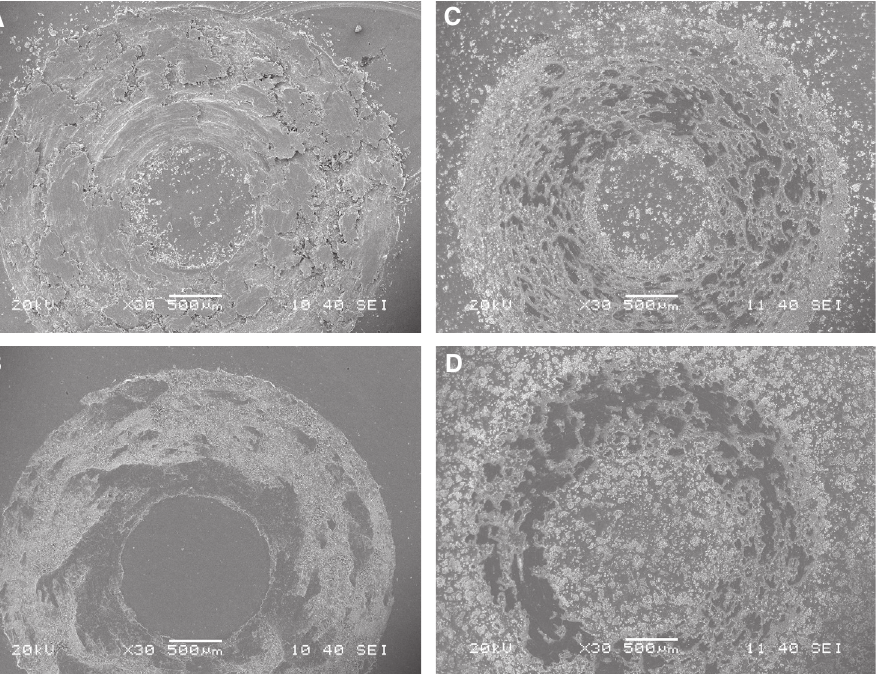
O and (B) Cu-5 vol.% Al 2 3